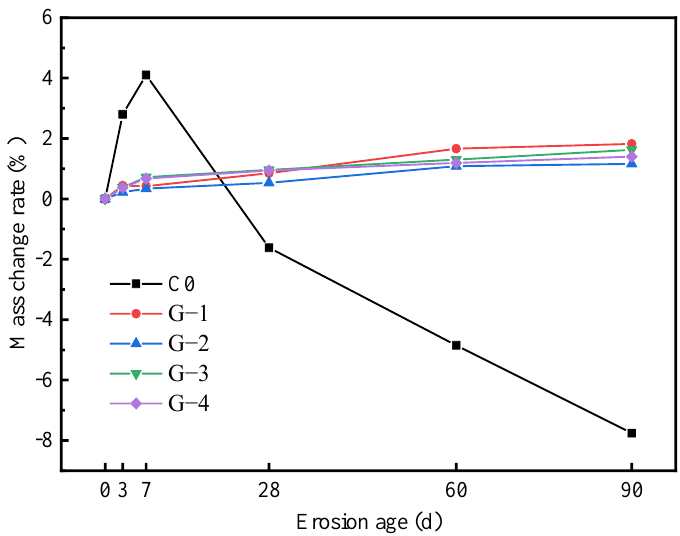
Figure 4. Mass change rate of stabilized soil immersed in sulfate erosion solution.